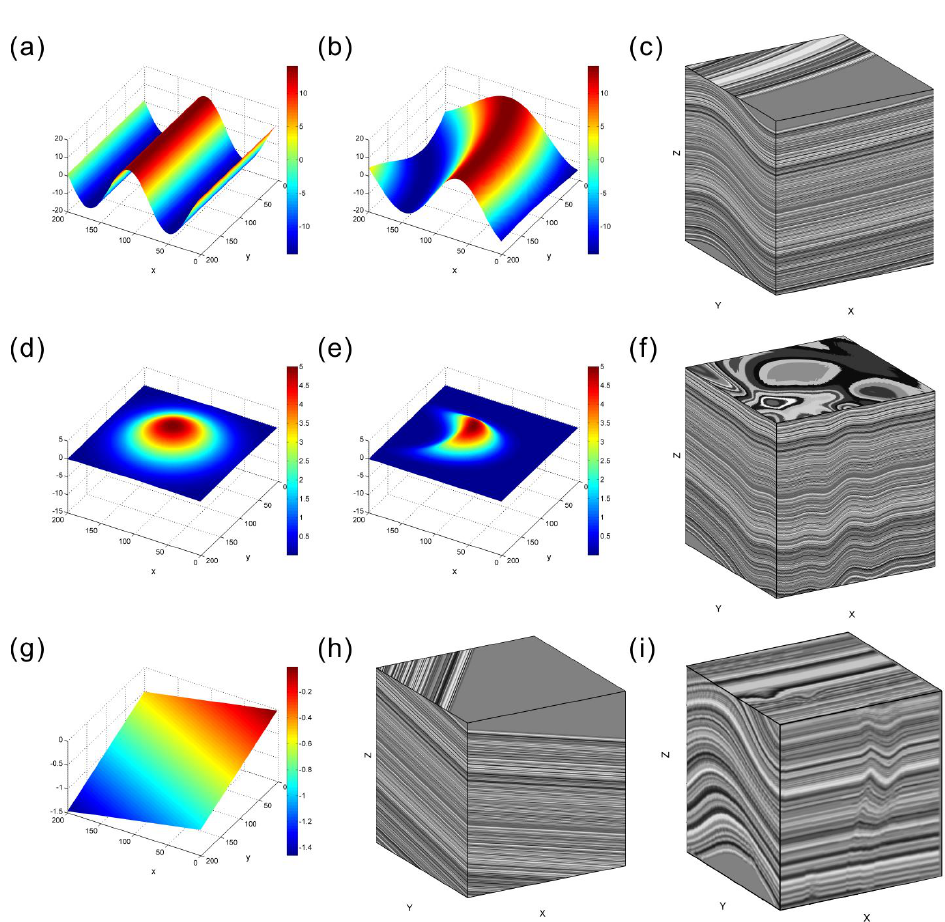
Figure 2. Demonstration of virtual folds. ( a ) A large-scale fold generated by the standard Fourier series. ( b ) A large-scale fold generated in this study. ( c ) A structure model with large-scale folds. ( d ) A local fold generated by the standard Gaussian function. ( e ) A local fold generated in this study. ( f ) A structure model with local folds. ( g ) Dips generated in this study. ( h ) A structure model with dips. ( i ) A structure model with multi-scale